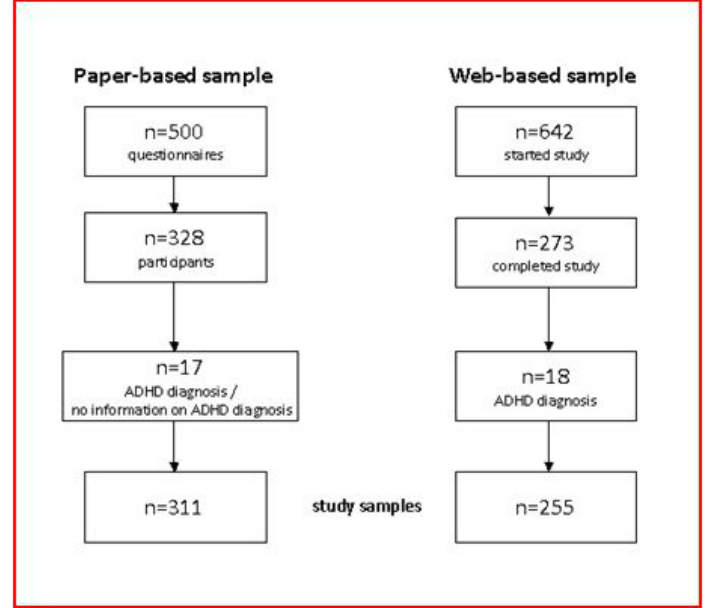
Figure 2. Flow of subjects in the paper-based and Web-based